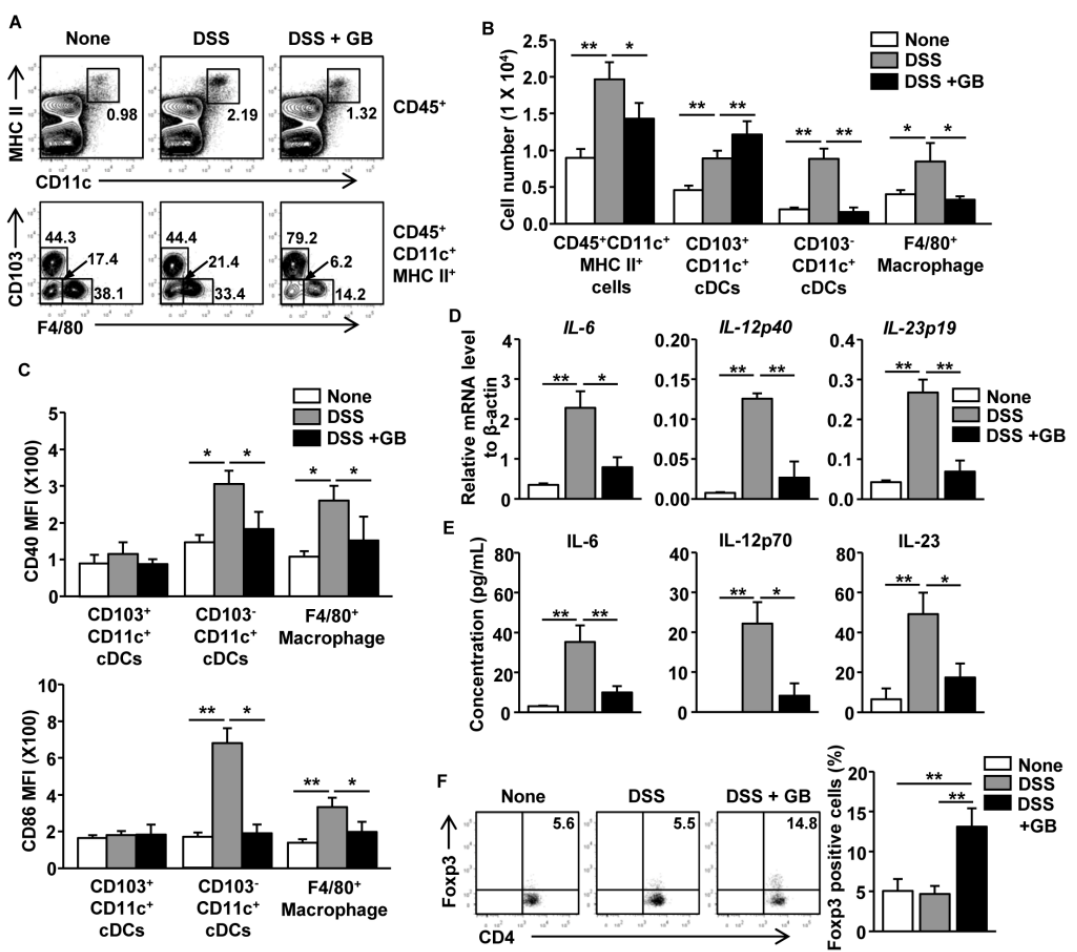
Figure 5. Ginseng berry extract (GB) inhibits recruitment and activation of CD103 - CD11c + dendritic cells (cDCs) and macrophages in the colon. Dextran sodium sulfate (DSS; 3%) was added to the drinking water of C57BL/6 mice and the mice were orally treated with GB or 0.9% saline for eight days. ( A ) Percentage of CD11c + MHC class II + in CD45 + cells (upper panels) and CD103 + , CD103 - , and F4/80 + cells in CD11c + MHC class II + CD45 + cells within colon-infiltrating mononuclear cells as determined by flow cytometry; ( B ) Means of absolute numbers of colon-infiltrating CD45 + CD11c + MHC class II + cells, CD103 + CD11c + cDCs, CD103 - CD11c + cDCs, and F4/80 + macrophages are shown; ( C ) Mean fluorescence intensity (MFI) of CD40 and CD86 are shown in the indicated cells; ( D ) Expression levels of IL-6, IL-12p40, and IL-23p19 mRNA were measured in colon tissues; ( E ) Concentrations of IL-6, IL-12, and IL-23 in colonic homogenates were determined by ELISA; ( F ) CD4 + Foxp3 + cells are shown in the colon (left panel), mean percentage of Foxp3 positive cells in CD4 T cells (right panel). All data are representative of/or the average of analyses of three independent experiments (total n = 6). Data shown are the mean ± SEM. * p < 0.05, ** p < 0.01.